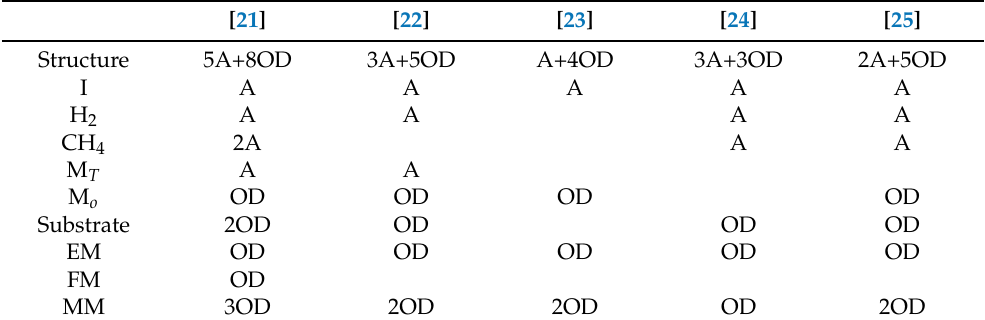
Table 1. Microbial electrolysis cell model classification based on ordinary differential algebraic equations